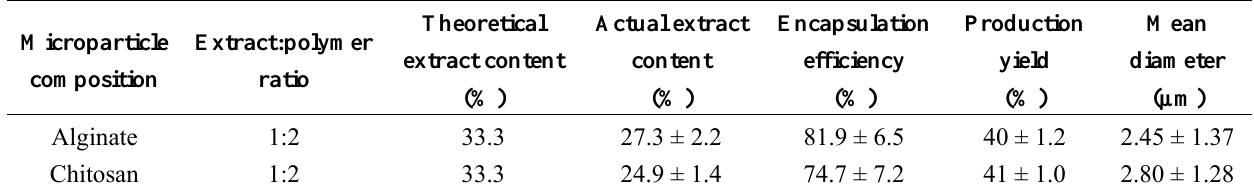
Table 1. Composition and production yields of spray-dried